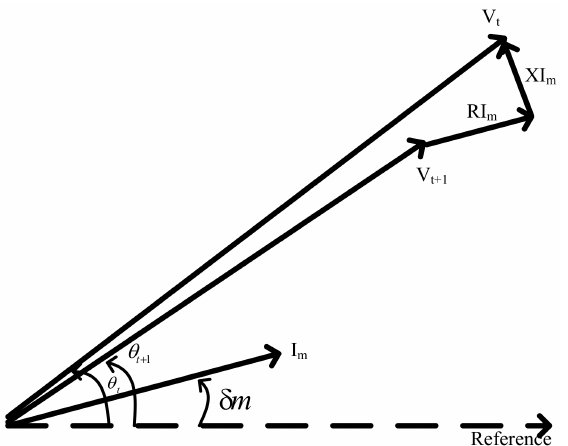
Figure 3. Phasor diagram of two consecutive nodes of a